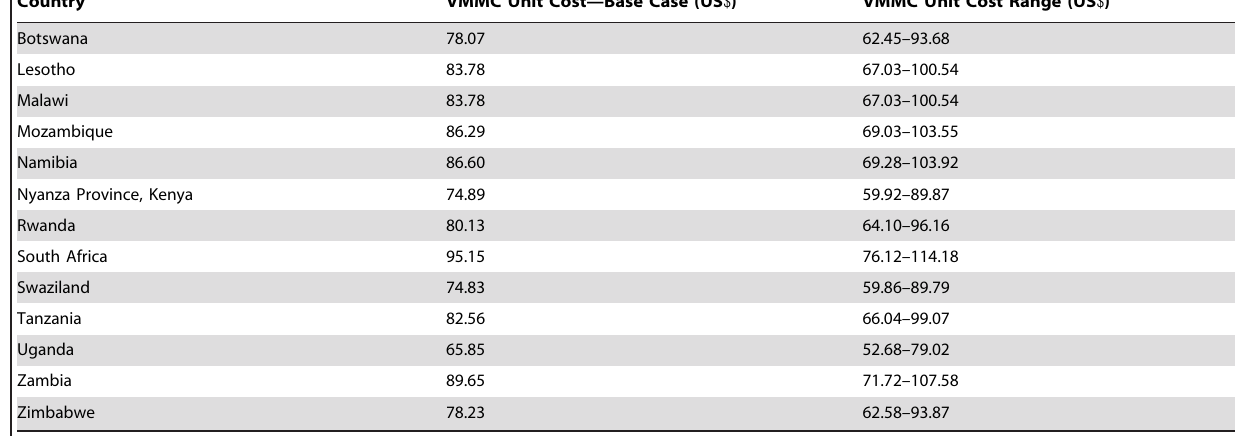
Table 3. VMMC unit cost by